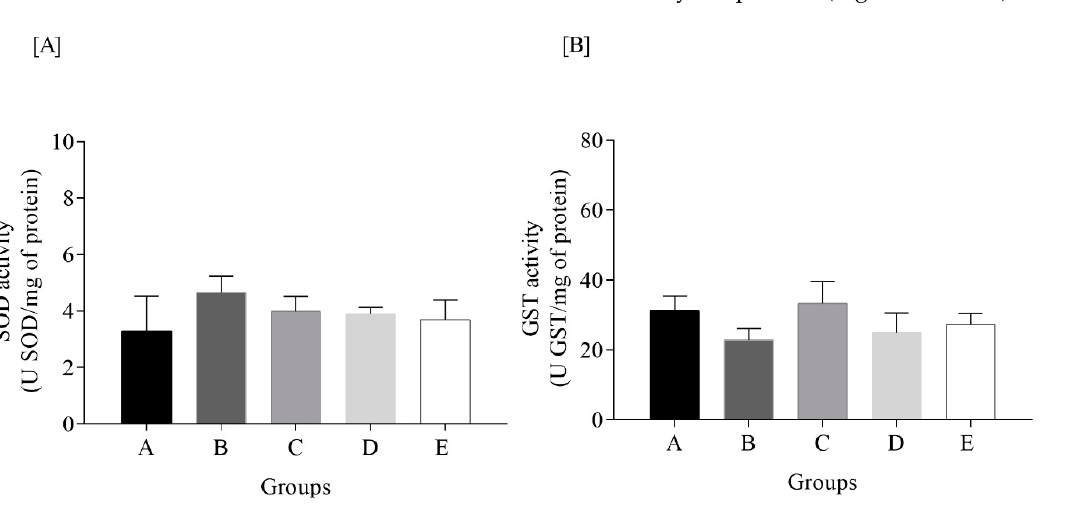
Figure 4. Oxidative status markers in the liver of silver catfish ( Rhamdia quelen ) fed with diets containing different concentrations of Cinnamomum cassia essential oil (CCEO) for 30 days ( A – D ). Letters of the bars: (A) Control diet; (B) supplementation of 0.25 mL of CCEO per kg of diet; (C) supplementation of 0.5 mL of CCEO per kg of diet; (D) supplementation of 1 mL of CCEO per kg of diet; (E) supplementation of 2 mL of CCEO per kg of diet. SOD: superoxide dismutase; GST: glutathione S-transferase; GPx: glutathione peroxidase; TBARS: thiobarbituric acid reactive species. Values are expressed as the mean ± SEM ( n = 8). * Asterisk indicates significant difference from control group (one-way ANOVA and Tukey’s test, p < 0.05). 4. Discussion According to Sutili et al. [36], an MIC value lower than 500 µ g/mL for plant extractives is considered strong inhibition with regard to the growth of bacteria isolated from fish. Based on this classification, the three substances tested in this study showed excellent MIC results. Treatment with the nanoemulsion potentiated the antibacterial activity of the CCEO, possibly because the nanoemulsion increases the solubility of EOs in water, and the culture medium used for the MIC test was aqueous [1,23]. The antibacterial in vitro effect of CCEO extracted from bark was demonstrated against Gram-positive bacteria ( Bacillus subtilis and Staphylococcus aureus ), Gram-negative bacteria ( Escherichia coli , Pseudomonas aeruginosa , and Salmonella typhimurium ) [37,38], and filamen- tous fungi and yeasts [39]. In a review, Doyle and Stephens [40] reported the antibacterial activity of cinnamaldehyde (the main constituent of CCEO) and its derivatives against several Gram-positive and Gram-negative bacteria. Therefore, cinnamaldehyde is probably one of the major compounds related to the antibacterial activity of this EO.